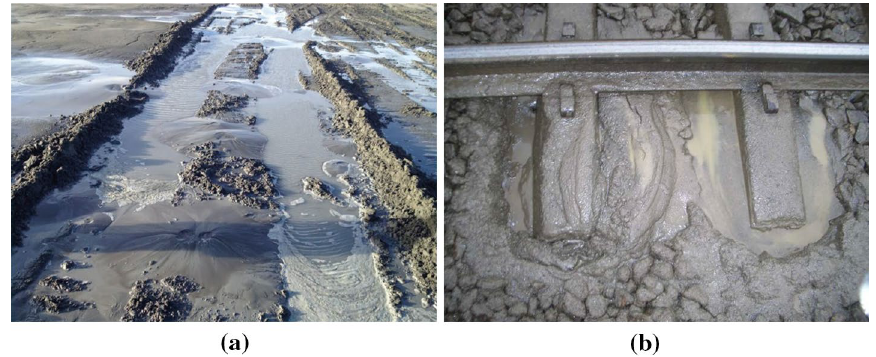
Fig. 1 Mud pumping phenomenon under cyclic traffic loading: (railway track (Trafikverket) and b porous piers in a tailings dam